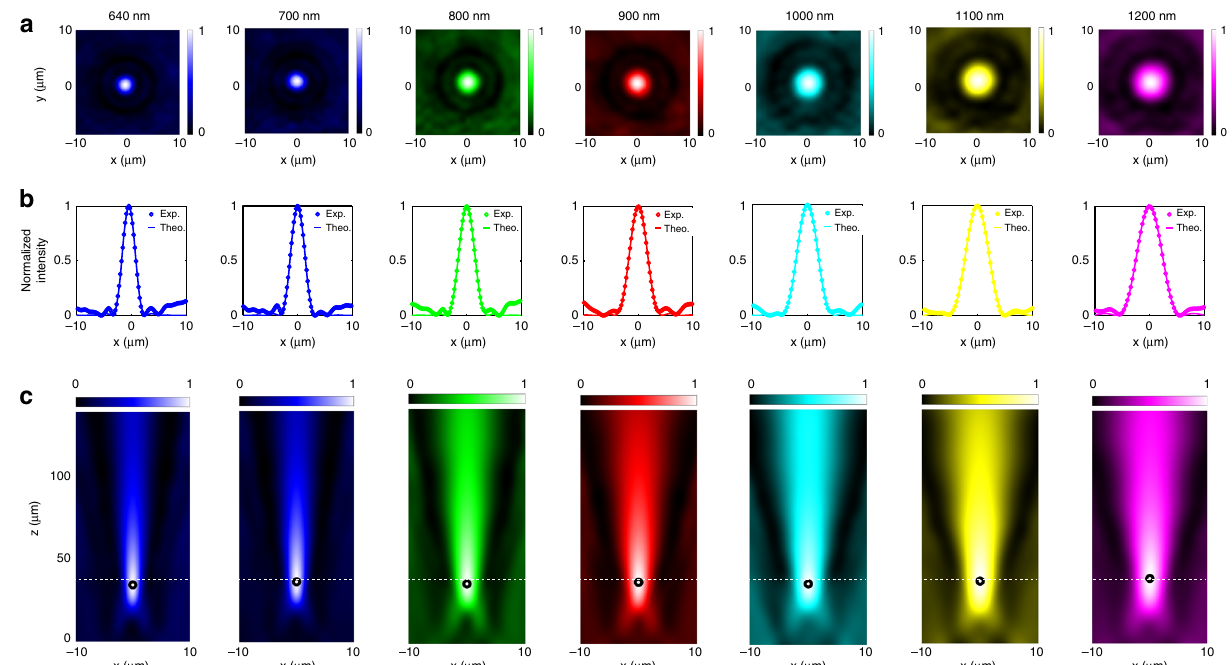
Fig. 3 Experimental demonstration of achromatic and broadband focusing by a FAM. a Measured intensity pro fi les in the focal plane z = F (transverse x – y plane) of the FAM, with a numerical aperture NA = 0.12, at different wavelengths from 640 to 1200 nm. b Normalized cross-section of the experimental measurements in a and the lines correspond to the theoretical airy disk. c Normalized intensity pro fi les in the plane y = 0 (axial x – z plane) around the focal point of the FAM at different wavelengths. Black circles represent the focal spots for different wavelengths.